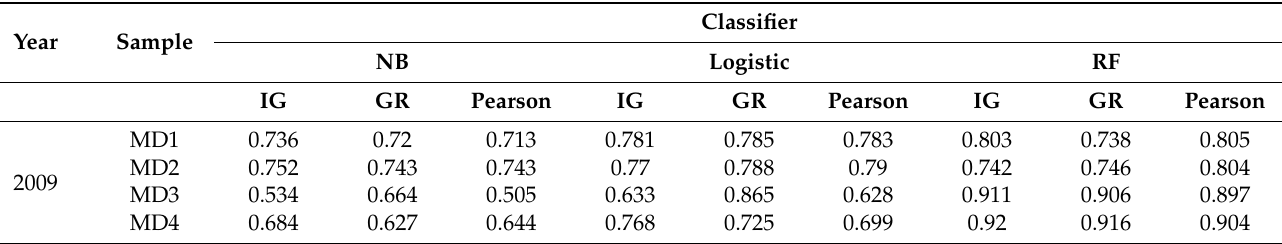
Table 6. The accuracy results for the different sample